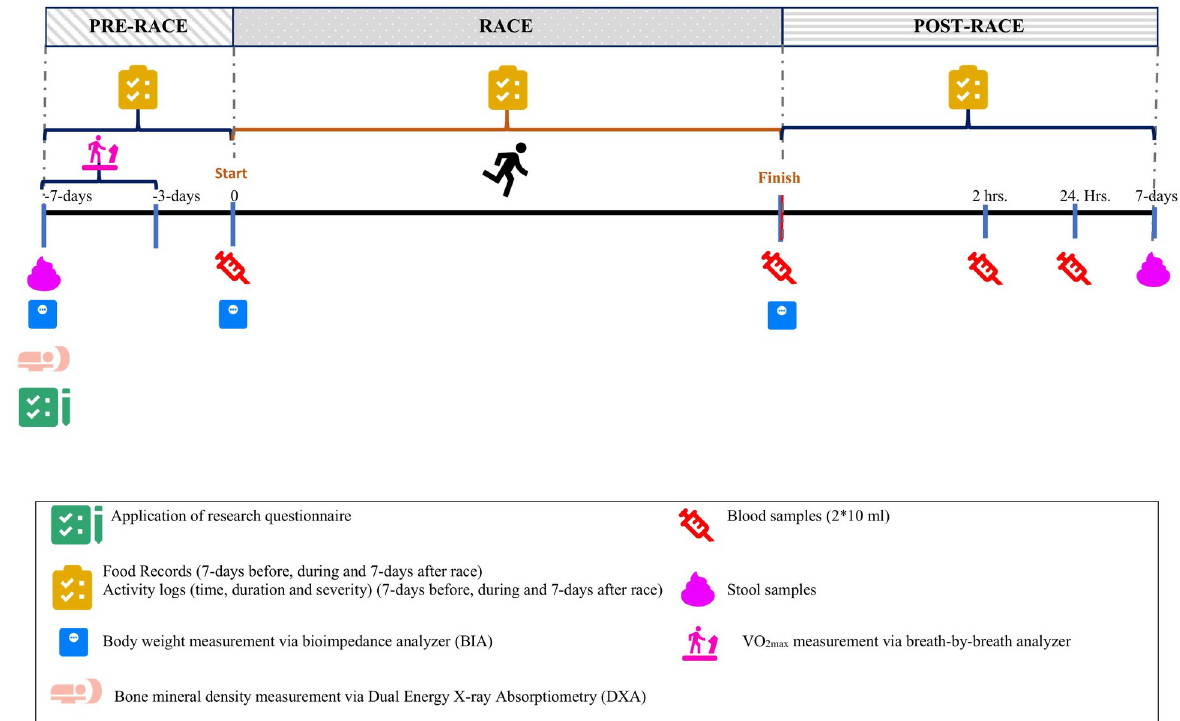
Fig 1. The flow chart of the